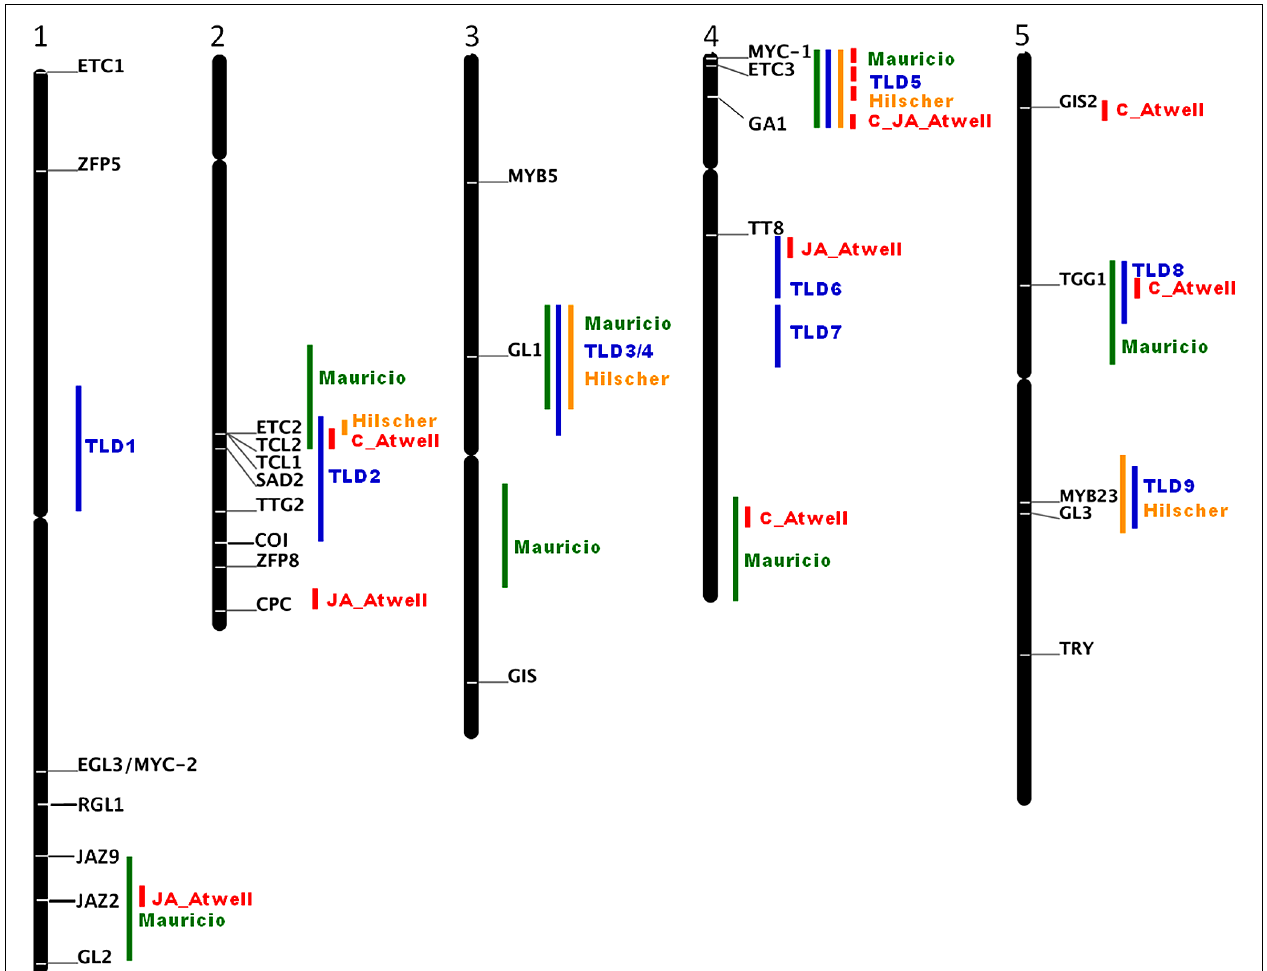
FIGURE 1 | Schematic representation of the loci influencing trichome density and number on rosette leaves from QTL analyses with different accessions (green; Mauricio, 2005), (blue; Symonds etal., 2005), (orange; Hilscher etal., 2009), and GWAS (red;Atwell etal., 2010). Indicated are the candidate genes that have been shown to influence trichome pattering and as bars the position of the QTL and GWAS loci. For GWAS only regions are indicated that contain the 200 most significant SNPs. AT3G27920 GL1